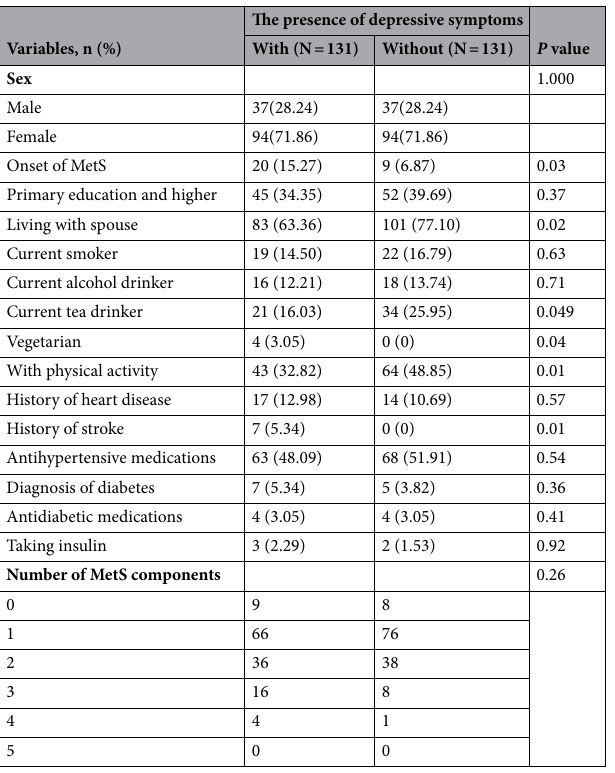
Table 1. Characteristics of participants with or without the presence of depressive symptoms (N = 262). MetS metabolic syndrome.